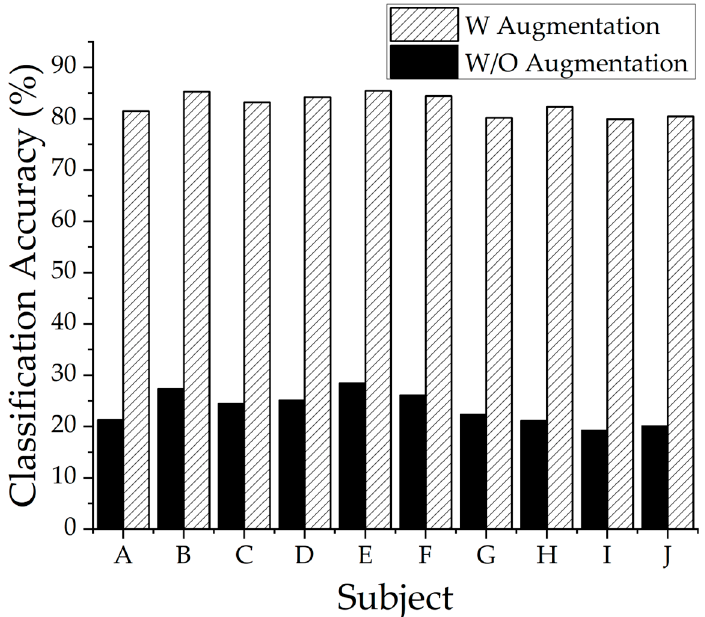
Figure 7. Data augmentation results for the proposed speed estimation method. Black and dashed line bar graphs represent the performance evaluation results for 60-m-long paths using the transfer learning model that learned the first training dataset and the second training dataset, respectively. The x -axis represents the anonymous identification of the subjects who participated in the experiment.